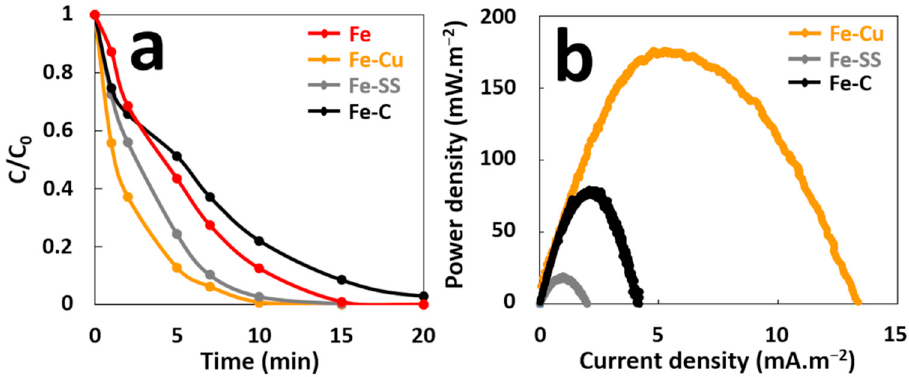
Figure 2. ( a ) Effect of cathode material on the decolorization of MG dye during the GF process, ( b ) Power curves of the GF process obtained with different cathode materials. ( b ) Power curves of the GF process obtained with different cathode